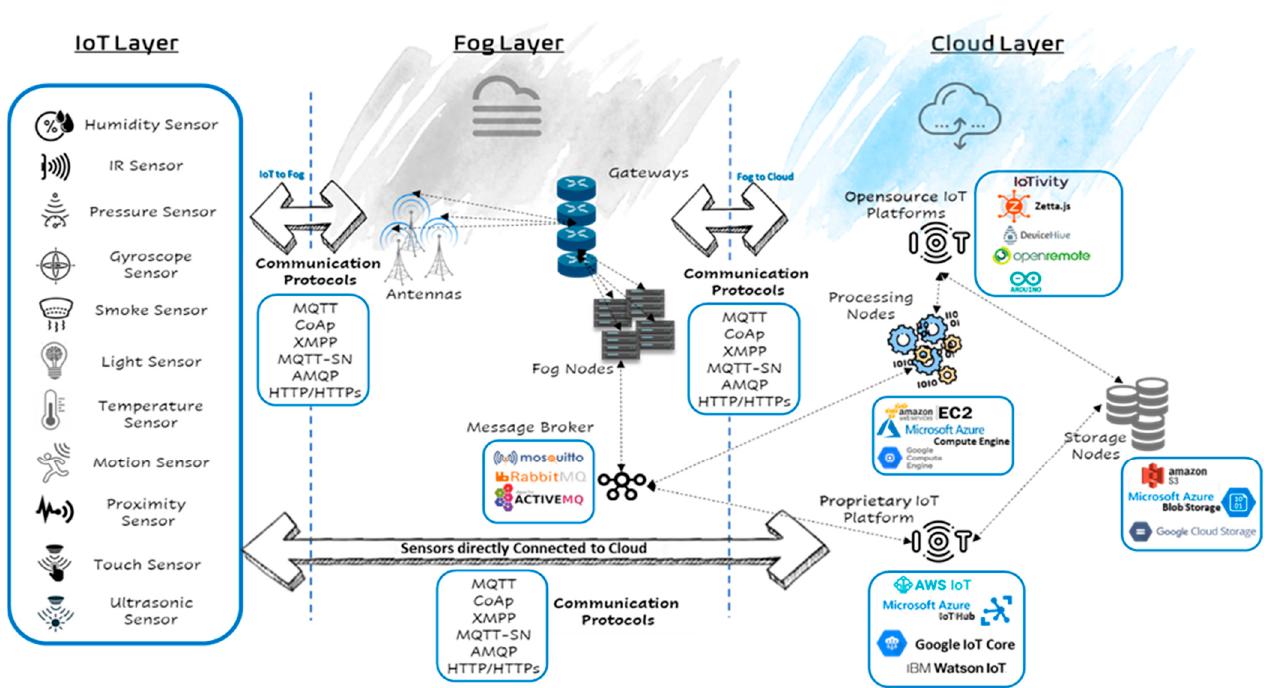
Figure 1. Overview of cloud-aided IoT environments.